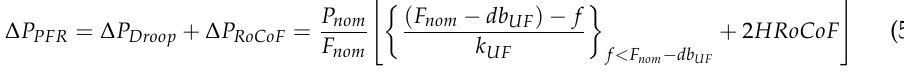
Figure 10. Classical Droop Control Method for Primary Frequency Response.